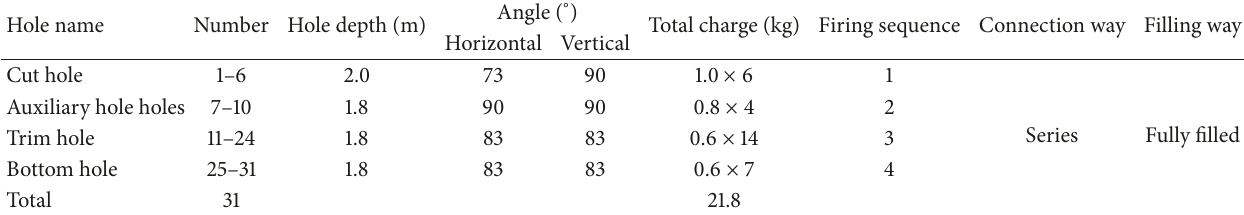
Table 5: Drilling pattern and charge weight in 2415